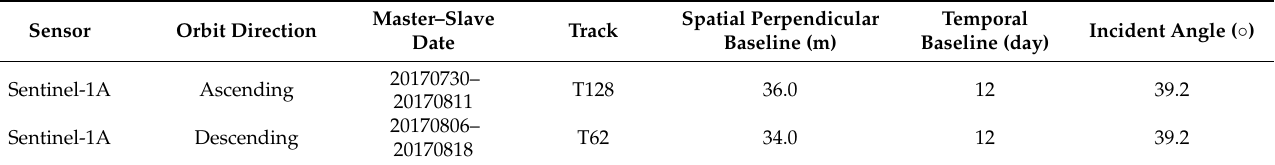
Table 1. Basic information of the SAR data used in the D-InSAR interferogram.